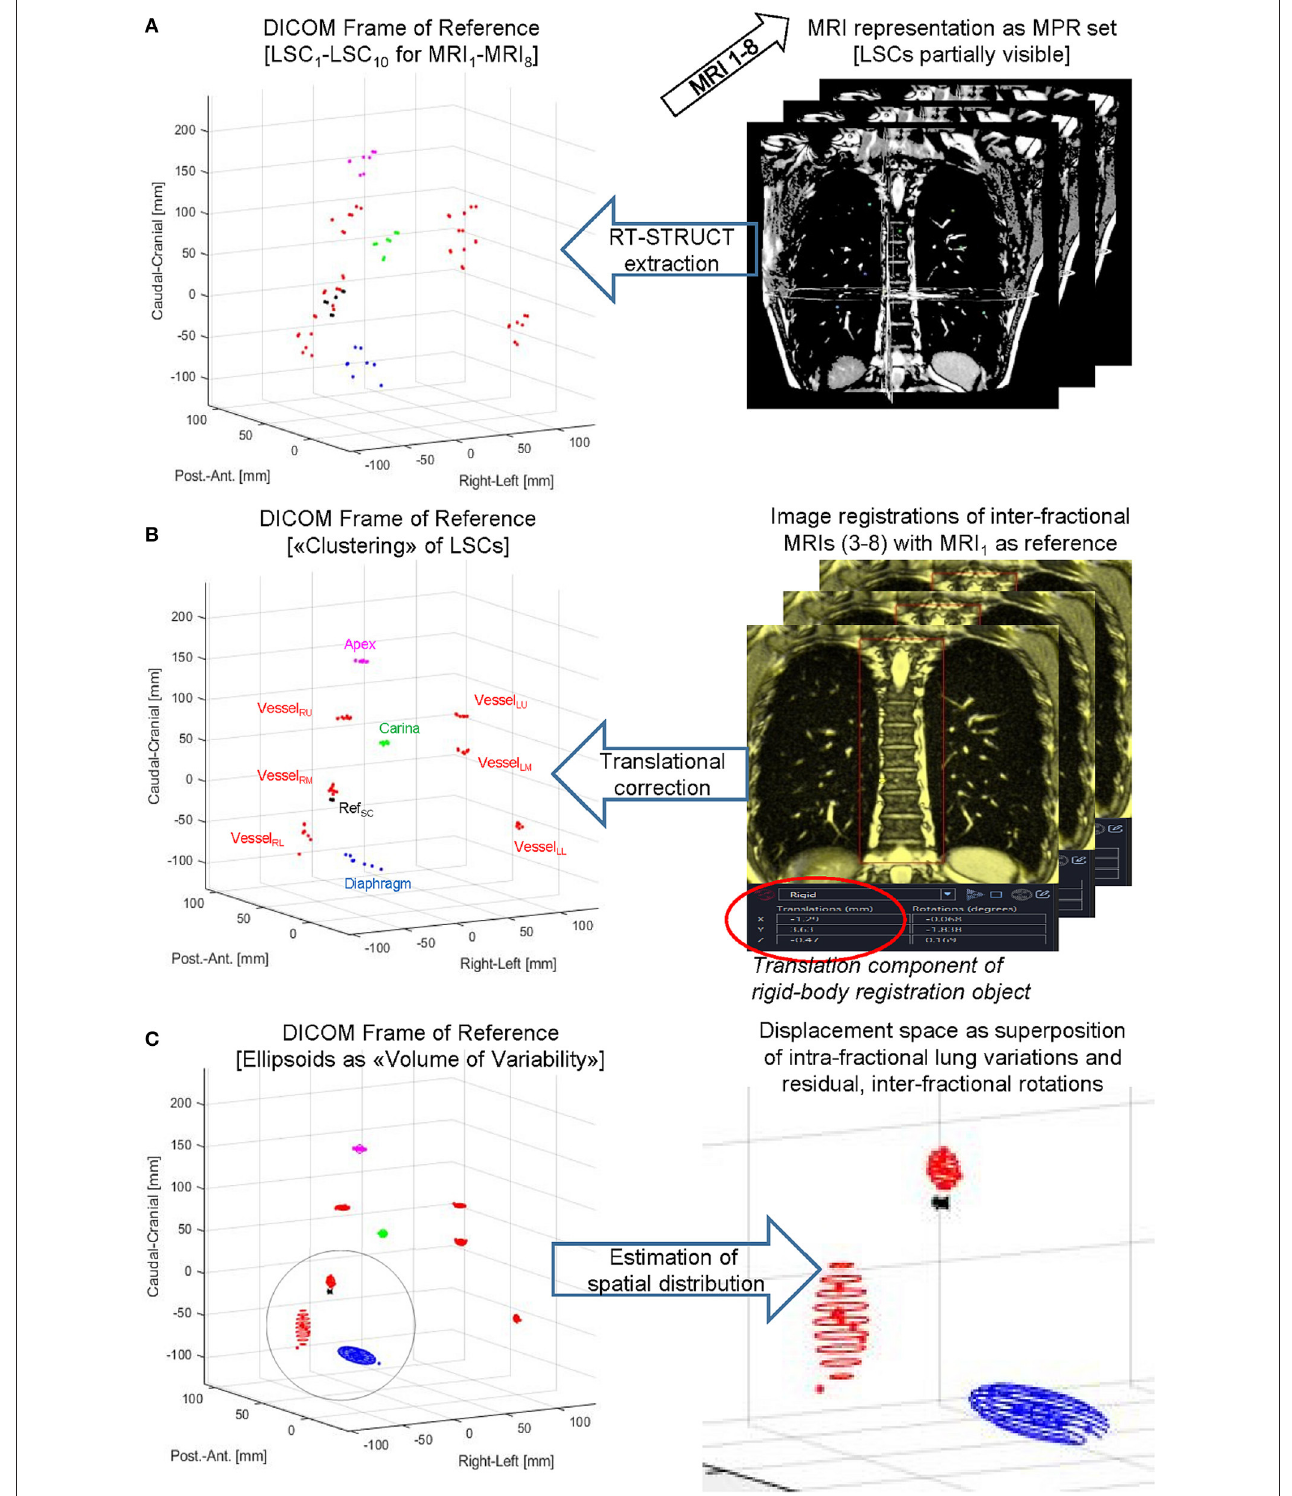
FIGURE 3 | LSC volumes of variability. Principal steps of displaying, processing, and analyzing a lung structure metric for a subject-specific set of eight MRIs acquired for eDIBH or HFPV. Top to bottom: LSCs were contoured as RT-STRUCT sets in Velocity ® (A) followed by DICOM export/import into MatLab to enable visualization in the common DICOM Frame of Reference. Subsequently (B) translation corrections determined by rigid-body image registrations were applied to the LSC distributions identified on left side graph, and (C) rotational ellipsoids to approximate their spatial distributions were calculated as described in the text.